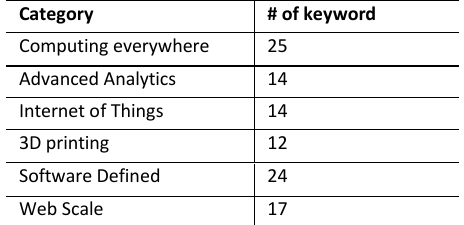
Table 2. The number of relevant keywords in each category.